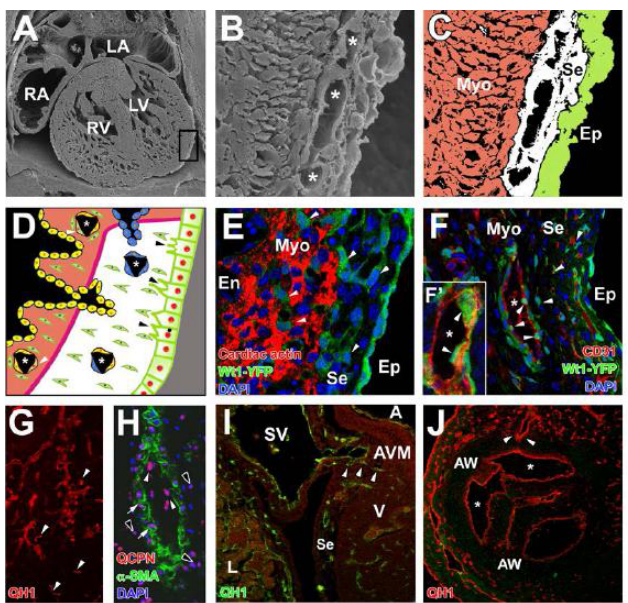
Figure 1. Coronary development in mouse and chick embryos. A (cid:177) C . The heart of a 15.5-day-old mouse embryo (E15.5) is shown. The boxed area in A is magnified in B , allowing for the identification of developing coronary vessels (asterisks). Tissue arrangement in that area is shown in C . D summarizes current hypotheses on the origin of coronary endothelium (CoE, asterisks). Sources for coronary endothelium include the ventricular (yellow) and sinus venosus (blue) endocardium, as well as epicardial-derived cells (green cells in coronary vessels, white arrowheads). Note that some epicardial epithelial cells (green) display morphological features of epithelial-to-mesenchymal transition (black arrowheads). E (cid:177) F. Epicardial-derived cell contribution to the developing heart can be traced in Wt1-Cre x ROSA26-eYFP (Wt1-YFP + ) embryos (E12.5, E ; E18, F ) by the expression of the eYFP reporter (green). Wt1-YFP + cells (arrowheads) progressively invade the subepicardial and myocardial layers and incorporate into developing coronary vessels, preferentially to prospective coronary arteries (asterisks). G (cid:177) J . Coronary blood vessel development in chick embryos. G . Part of the primitive coronary capillary plexus (QH1 + , red) forms by coalescence of isolated vascular (cid:83)(cid:85)(cid:82)(cid:74)(cid:72)(cid:81)(cid:76)(cid:87)(cid:82)(cid:85)(cid:86)(cid:3) (cid:11)(cid:181)(cid:68)(cid:81)(cid:74)(cid:76)(cid:82)(cid:69)(cid:79)(cid:68)(cid:86)(cid:87)(cid:86)(cid:182)(cid:15)(cid:3) (cid:68)(cid:85)(cid:85)(cid:82)(cid:90)(cid:75)(cid:72)(cid:68)(cid:71)(cid:86)(cid:12)(cid:17)(cid:3) H . Chimeric transplantation of embryonic quail proepicardia into recipient chick embryos allows for the following and studying of the developmental fate of cells from the epicardial lineage. Epicardial-derived cells (QCPN + , purple) are found in the endothelium (white arrowheads), the medial smooth muscle wall ( (cid:68) -SMA + , green) and the fibrous adventitia (black arrowheads). I . Sinus venosus endocardium also contributes to the development of the coronary vascular system in chick embryos. SV endocardial sprouts (QH1 + , arrowheads) use the subepicardial space to immigrate into the ventricle. J . The preformed arterial component of the coronary vascular plexus joins the systemic blood flow at the aortic root (QH1 + , red). Some of these capillaries (arrowheads) cross the forming aortic wall and open to coronary Valsalva sinuses (right and left, asterisks). Abbreviations: AVM, atrioventricular myocardium; AW, aortic wall; En, endocardium; Ep, epicardium; Myo, myocardium; Se, subepicardium; SV, sinus venosus. Panel J is reprinted with the permission of Academic Press